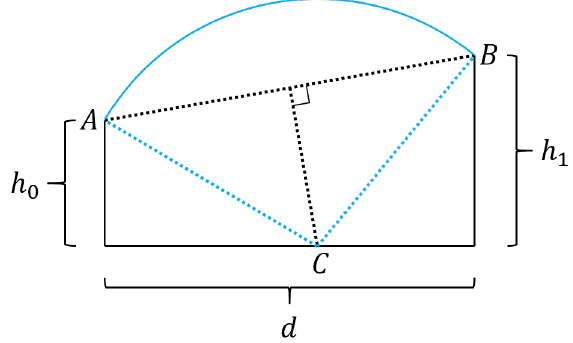
Figure 22. A slice perpendicular to the x 0 − τ 0 plane. The solid blue line is the geodesic, C is the center of geodesic, A and B are the ending points on the RT surfaces, h 0 and h 1 are the values of the z 0 coordinate of A and B , d is the distance of the projection of A and B on x 0 − τ 0